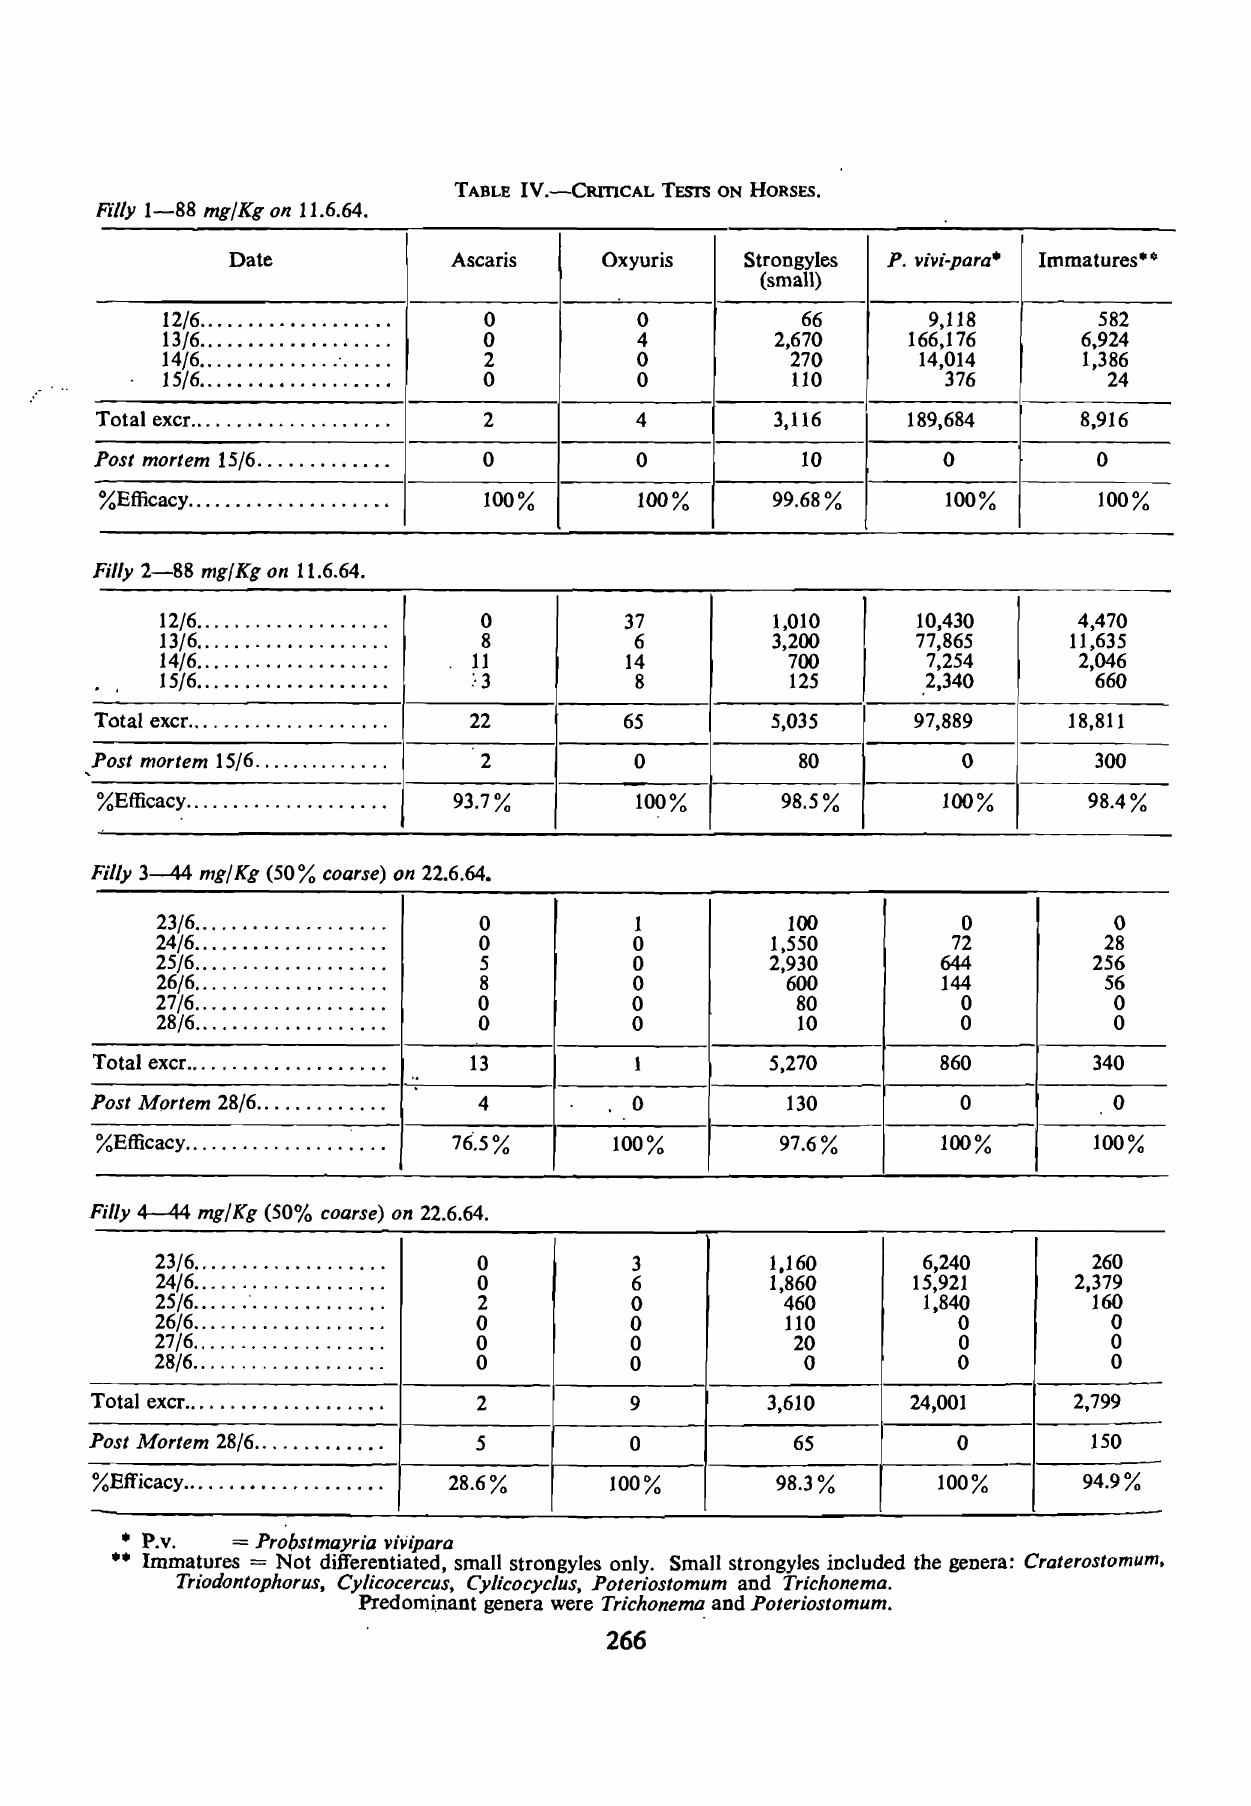
Filly 1-88 mg/Kg on 11.6.64.